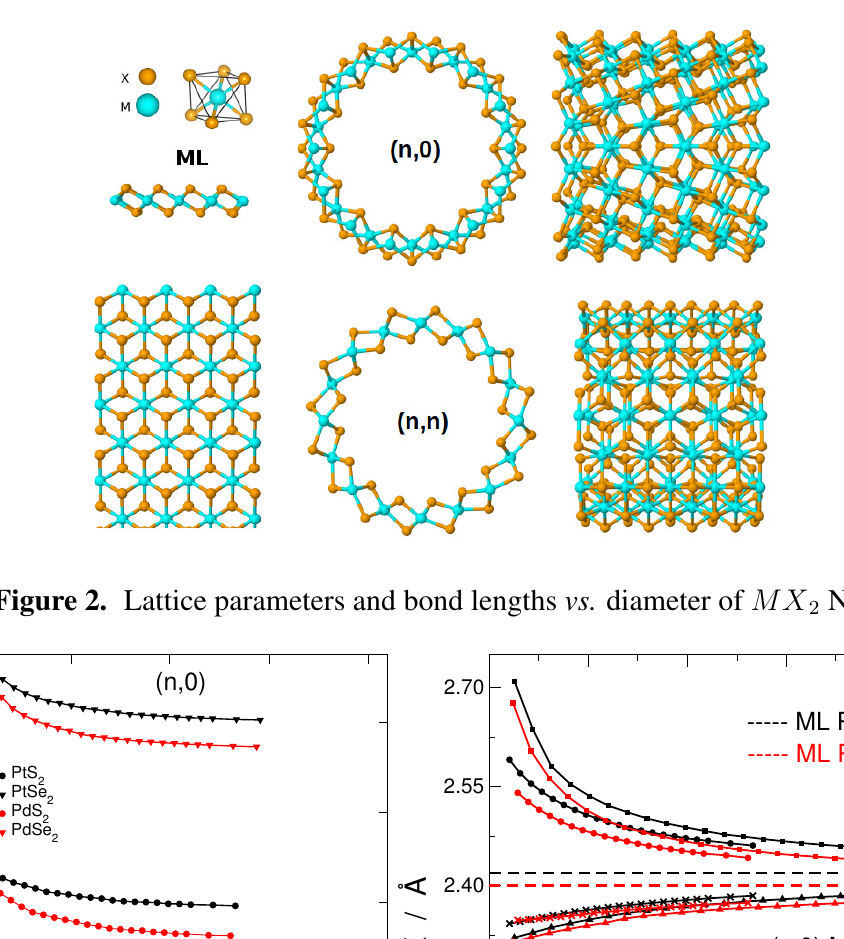
Figure 1. 1 T 2D (monolayer) and 1D (tubular) forms of noble metal chalcogenides. The unit cell of 2D systems is shown.